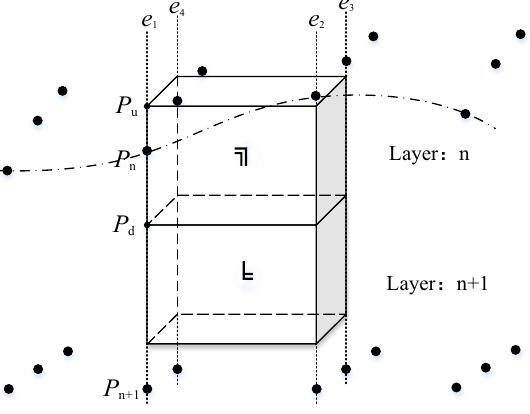
Figure 4. Schematic diagram of voxel